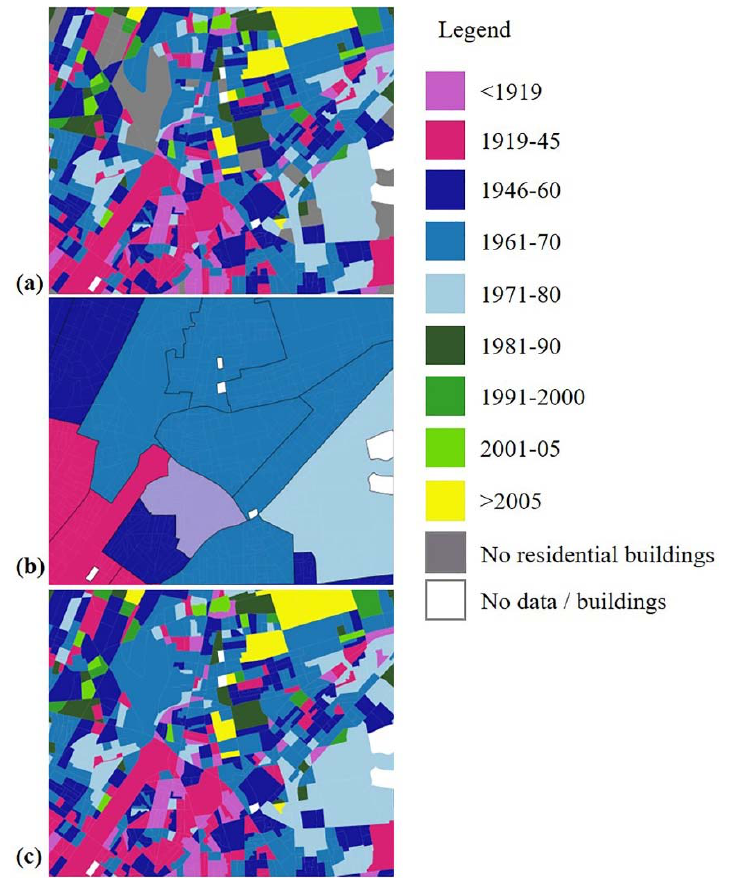
Figure 5. Determination of the prevailing period of construction of each Census Unit having resi- dential building units ( a ) and of the prevailing period of construction of each Census Area ( b ) for assigning it to each nonresidential Census Unit ( c ).